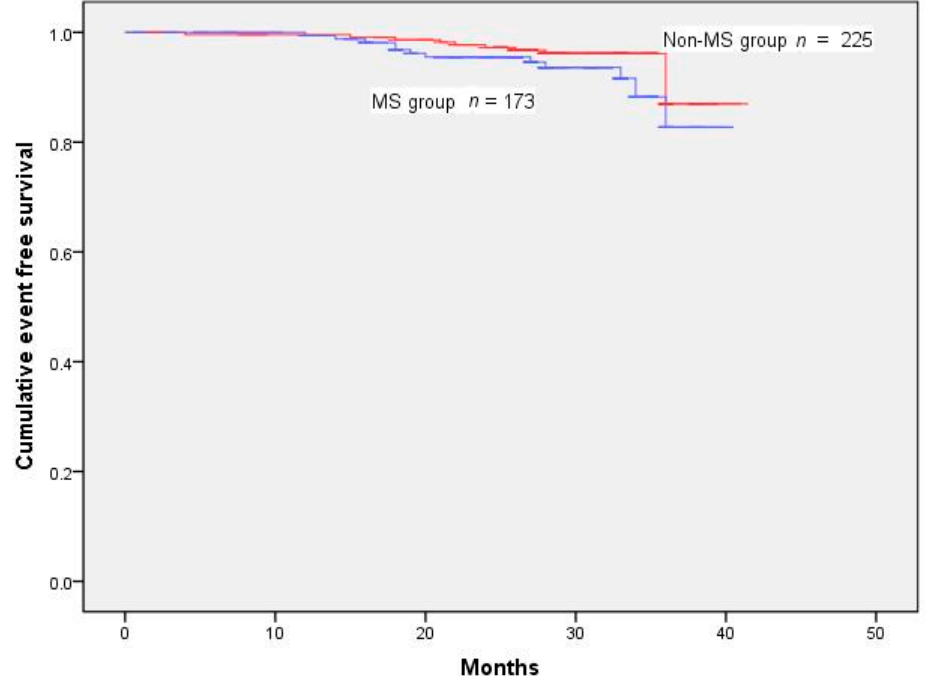
Figure 4. Cumulative survival rates censored for all-cause death. Survival rates were similar between the groups (log-rank test p = 0.060).